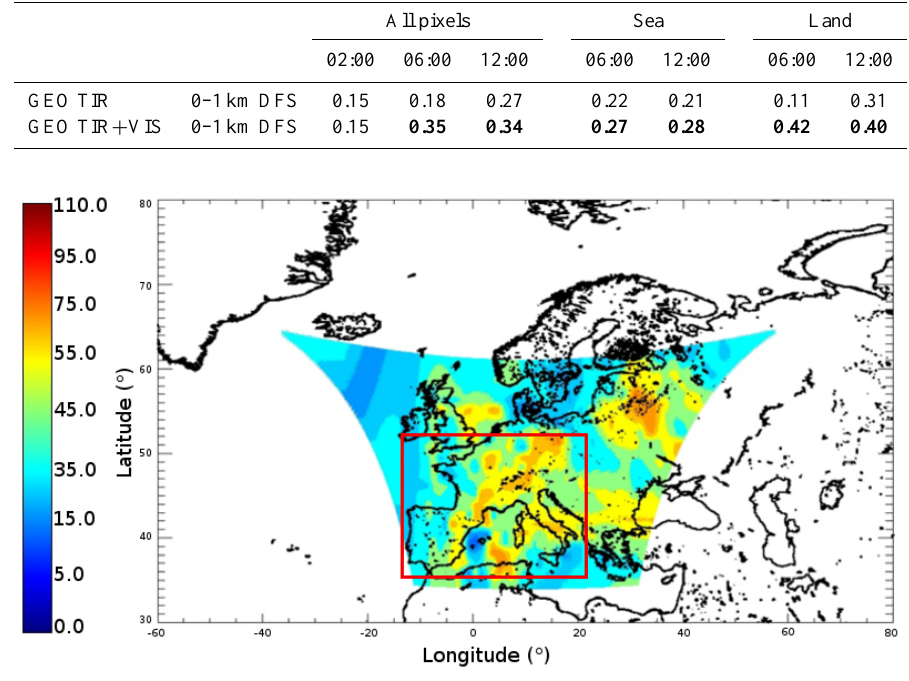
Figure 2. Image of the surface ozone field from MOCAGE 11 July 2009 at 12:00UTC simulated with the field of view and the spatial resolution of the MAGEAQ geostationary instrument ( ∼ 15 km × 15 km). The colour bar indicates the ozone concentration in parts per billion by volume (ppbv), with red/blue indicating relatively high/low values. The red square indicates the domain of ozone simulation with the MOCAGE grid (0 . 5 ◦ × 0 . 5 ◦